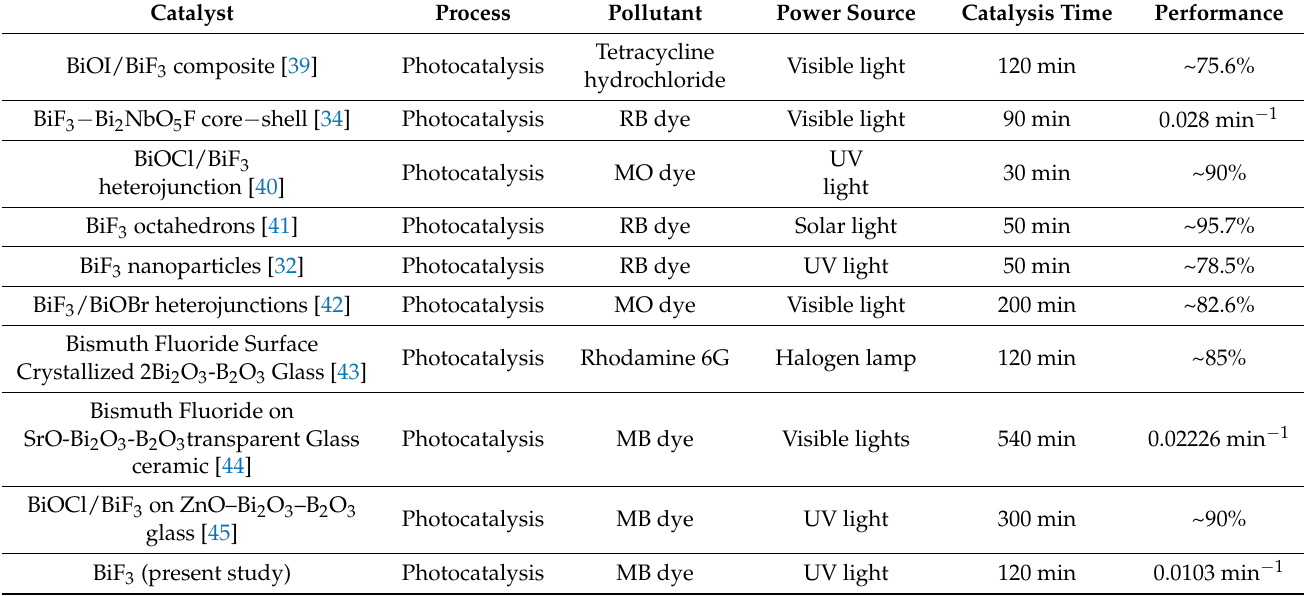
Table 1. Comprehensive study of photocatalysis activity of BiF 3